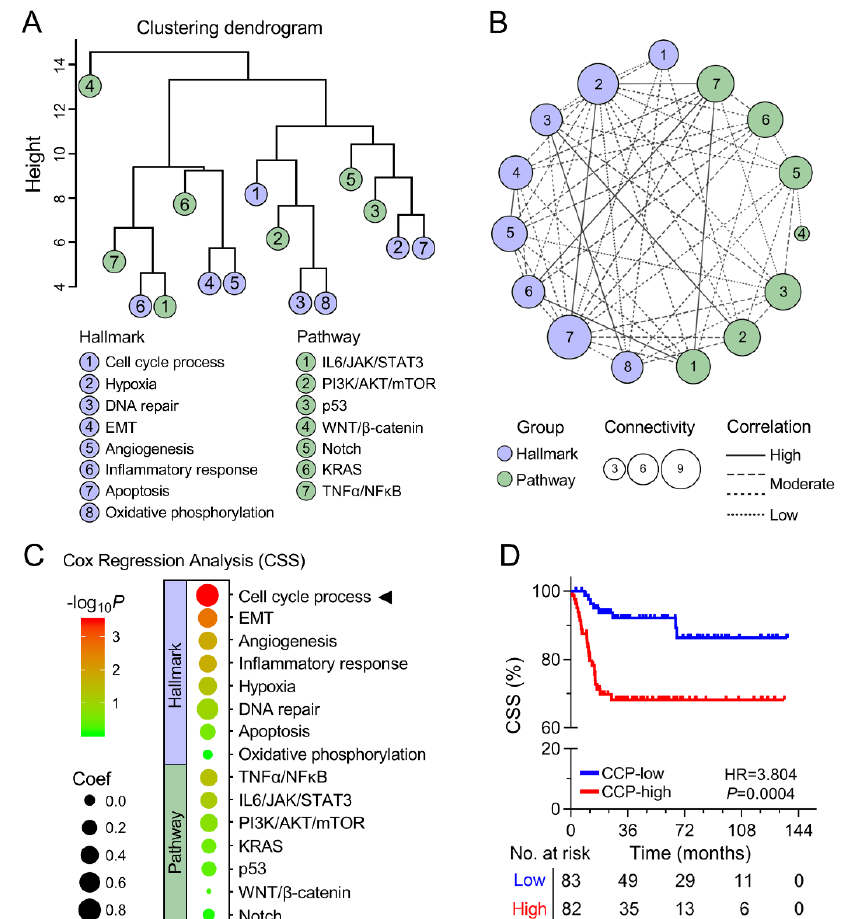
Figure 2. CCP was identified as the primary risk factor for CSS. ( A ) Hierarchical clustering dendrogram was generated to show the distance between different hallmarks and pathways. ( B ) A network was constructed to depict relationships between different hallmarks and pathways. (C ) Bubble heatmap of Cox results indicated that CCP serves as the most powerful risk factor for